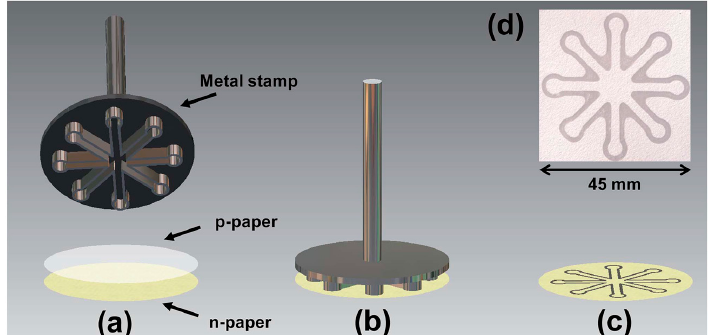
Figure 1. Scheme of the typical stamping process for microfluidic paper-based analytical devices